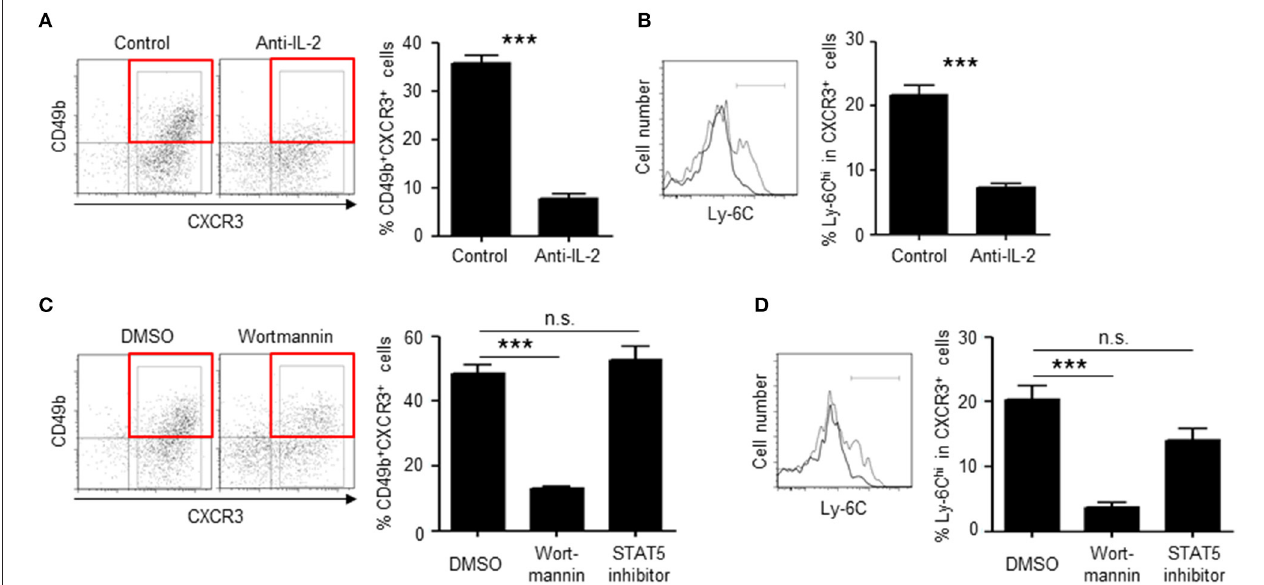
FIGURE 7 | IL-2 enhances the differentiation of memory precursors via PI3K in vitro . (A,B) Blockade of IL-2 reduces the frequency of CD49b + CXCR3 + subpopulation in in vitro -activated CD4T cells. Naive CD4T cells from C57BL/6 mice were stimulated with anti-CD3/CD28 for 48h in the presence of anti-IL-2 or isotype control and then incubated for 48h. The frequencies of CD49b + CXCR3 + in activated CD4T cells (A) and Ly-6C hi cells in CXCR3 + activated CD4T cells (B) are shown. (C,D) Inhibition of PI3K reduces the frequency of CD49b + CXCR3 + subpopulation in in vitro -activated CD4T cells. Naive CD4T cells from C57BL/6 mice were stimulated with anti-CD3/CD28 for 48h in the presence of Wortmannin, STAT5 inhibitor or DMSO and then incubated for 48h. The frequencies of CD49b + CXCR3 + in activated CD4T cells (C) and Ly-6C hi cells in CXCR3 + activated CD4T cells (D) are shown n = 6. These data are representative of two independent experiments. Data are shown as mean ± SD. *** p < 0.001, n.s.: not